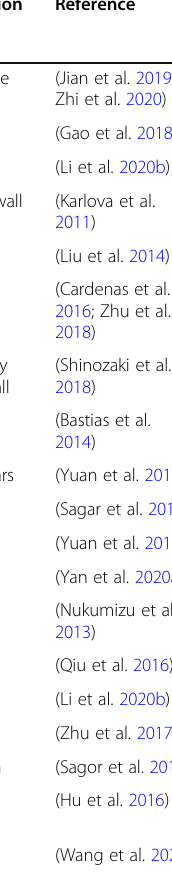
Table 1 Validated structure and transcriptional genes of tomato fruit quality metabolism (Continued) Metabolite pathway or TF